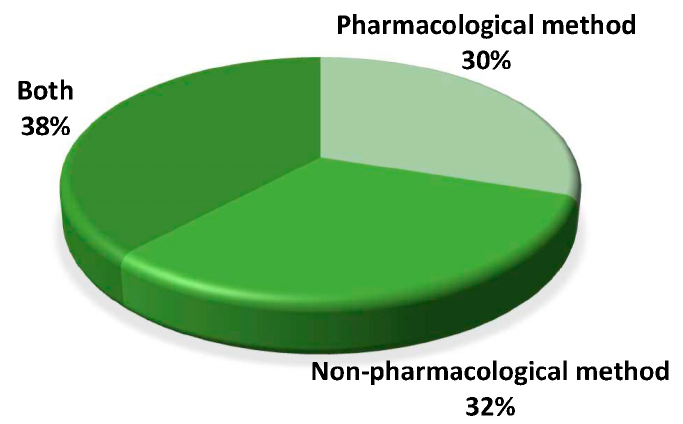
Figure 6. Type of management mentioned in the videos.